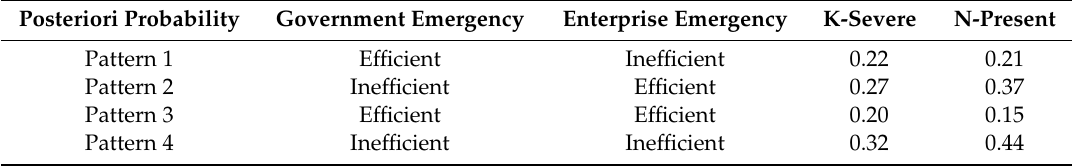
Table 4. Estimated probability of accident consequences under di ff erent emergency response